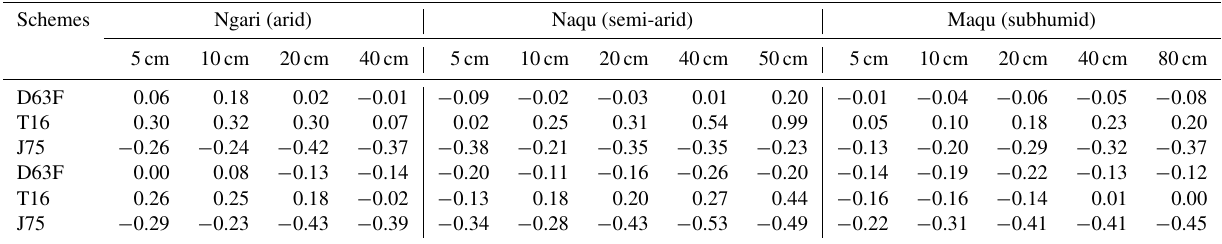
Table 3. Biases of λ estimates based on D63F, T16 and J75 schemes combined with the BD scheme in the profiles across the three climate zones and the measurements. Case 1 is the bias (listed in the upper part of the table) derived from schemes not considering gravel impact parameterization for the arid and semi-arid zone or SOC impact parameterization for the subhumid zone. Case 2 is the bias (listed in the lower part of the table) with these parameterizations taken into consideration. The unit of the listed values is Wm − 1 K − 1